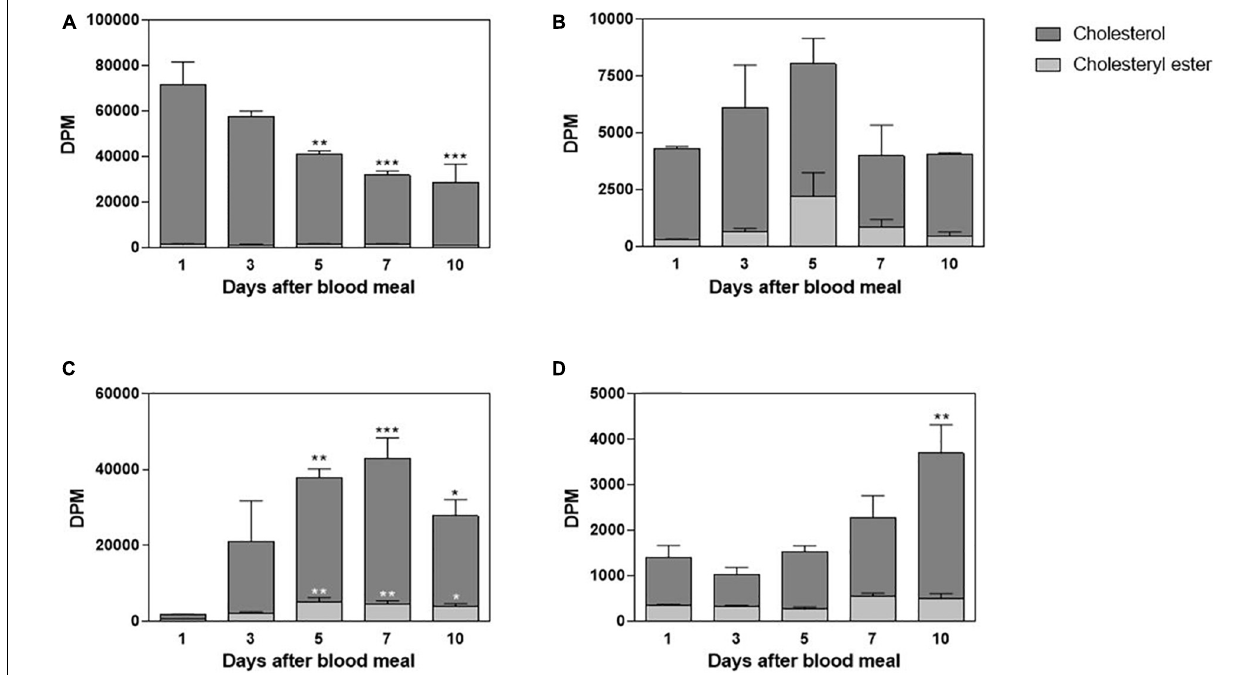
FIGURE 1 | Cholesterol absorption by the midgut. Rhodnius prolixus adult females were fed on 3 H-cholesterol-enriched blood and dissected on different days after the blood meal. Lipids from anterior midgut content (A) and tissue (B) , as well as from posterior midgut content (C) and tissue (D) , were extracted and analyzed by HPTLC. Radioactivity associated with free cholesterol (dark bars) and esterified cholesterol (light bars) was quantified and expressed as DPM/content or tissue ± SEM for three to four determinations. (*), (**), and (***): significantly different from day 1 after analysis by one-way ANOVA followed by Dunnett’s posttest, p < 0.05, p < 0.01, and p < 0.001, respectively. HPTLC, high-performance thin-layer chromatography; DPM, disintegrations per minute.